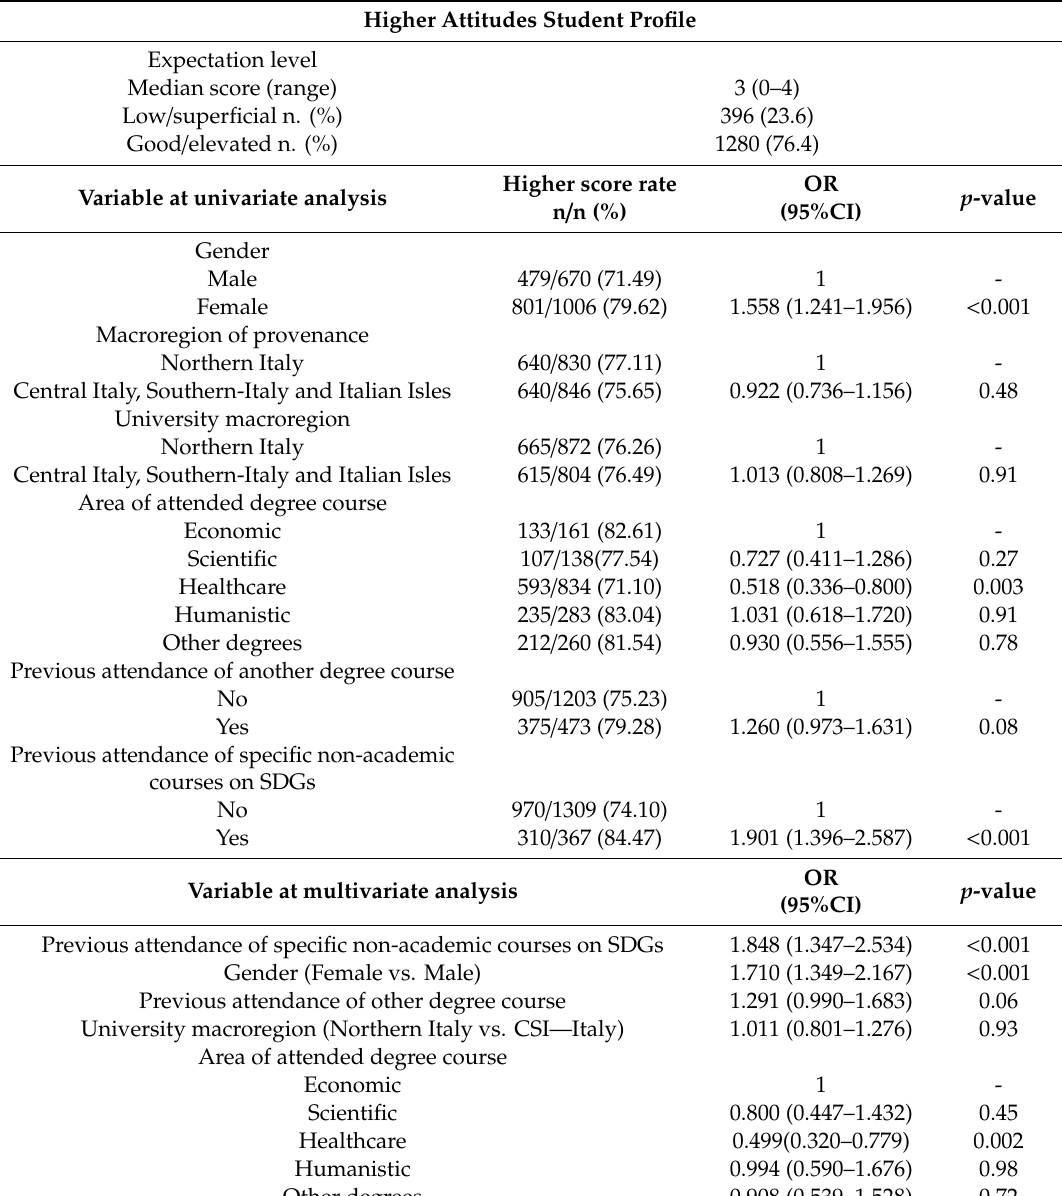
Table 4. Univariate and multivariate analysis for attitudes towards SDGs and 2030